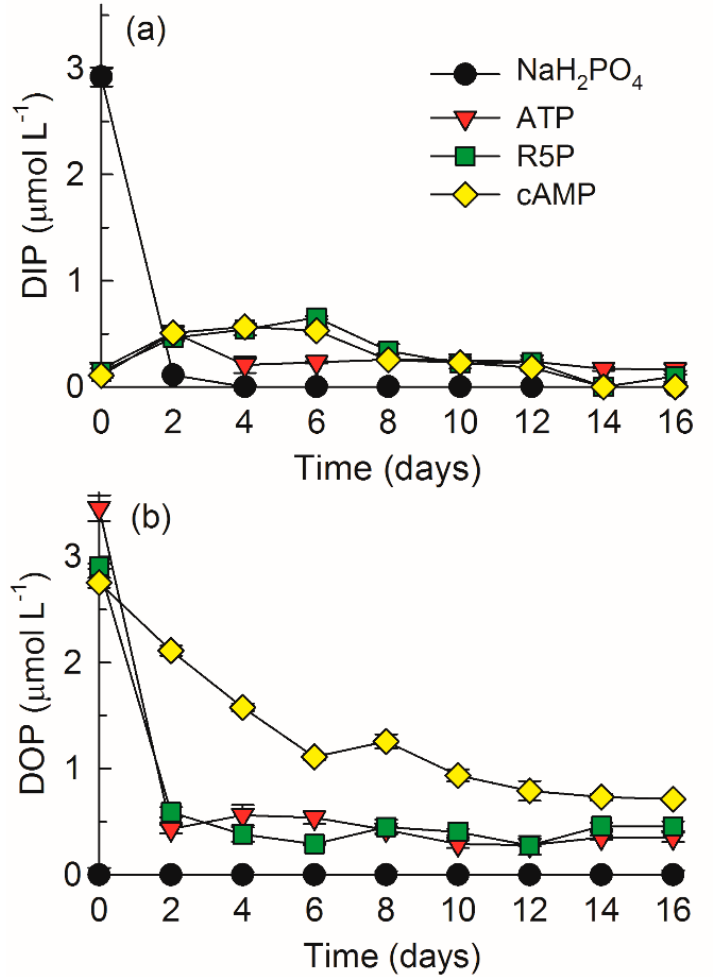
Figure 1. Concentrations of dissolved inorganic phosphorus (DIP) ( a ) and dissolved organic phosphorus (DOP) ( b ) in the NaH 2 PO 4 , adenosine triphosphate (ATP), ribulose 5-phosphate (R5P), and cyclic adenosine monophosphate (cAMP) treatments. The values are the mean ± S.D. ( n = 3). DOP was undetectable in the NaH 2 PO 4 treatment during the whole study (Figure 1b). DOP decreased sharply from 3.46 ± 0.12 µ mol L − 1 and 2.91 ± 0.02 µ mol L − 1 to approxi- mately 0.50 µ mol L − 1 in the first two days and fluctuated thereafter in the respective ATP and R5P treatments. In contrast, in the cAMP treatment, DOP decreased gradually from 2.75 ± 0.05 µ mol L − 1 at the beginning to 0.71 ± 0.01 µ mol L − 1 at the end of the experiment.